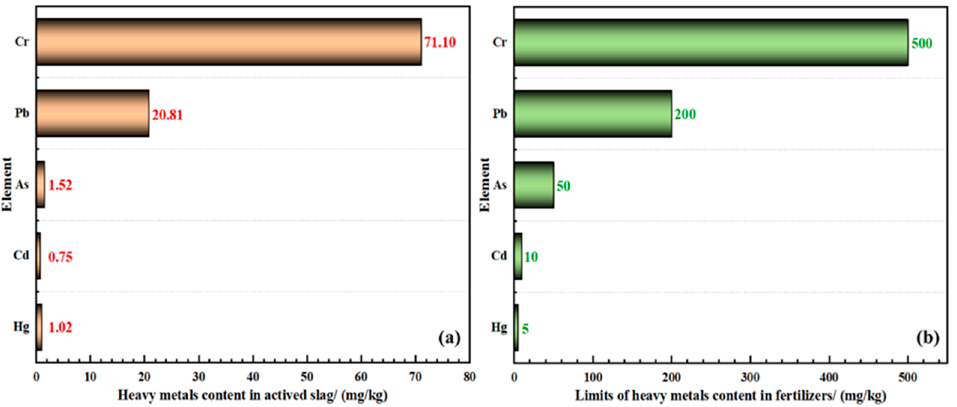
Figure 8. ( a ) Heavy metals leaching toxicity test for active slag; ( b ) Limits of heavy metals content in fertilizers.